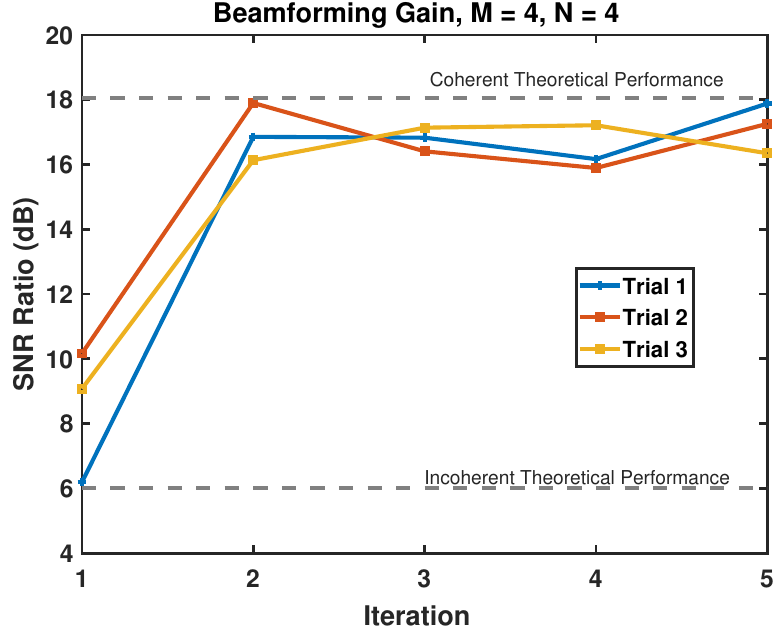
Figure 11. Experimental results for the 1-4-4-1 distributed mesh relay network. The y-axis represents the effective increase in SNR at the final receiver as a result of the distributed relay and multi-stage beamforming compared to the equivalent single input, single output (SISO) direct link. Channel state information is not available until after the first transmit and receive cycle, so the first measurement is limited to incoherent beamforming